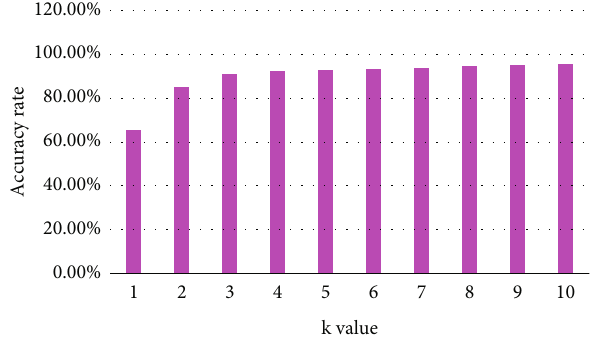
Figure 4: Accuracy rate for various K -values. Table 5: E ff